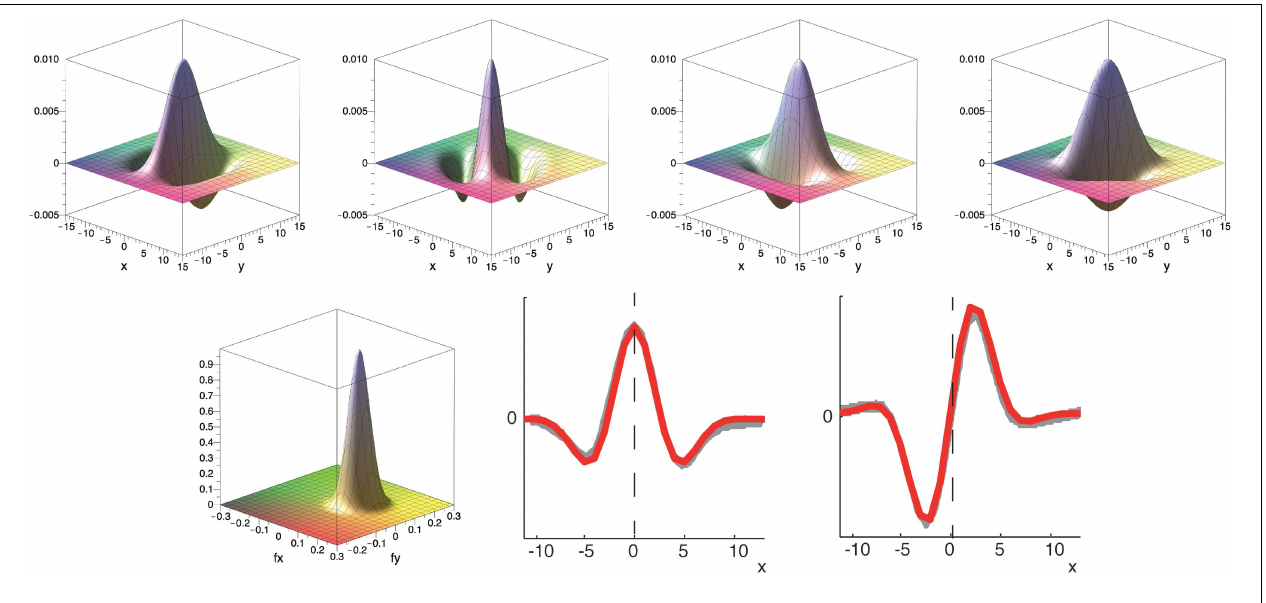
FIGURE 5 | Top row: Example of filter bank of four oriented Gabor filters for 8 [ 0 ◦ , 45 ◦ , 90 ◦ , 135 ◦ ] (to resemble the spatial receptive field weights; only = even component is shown). Bottom row: Corresponding filter in Fourier